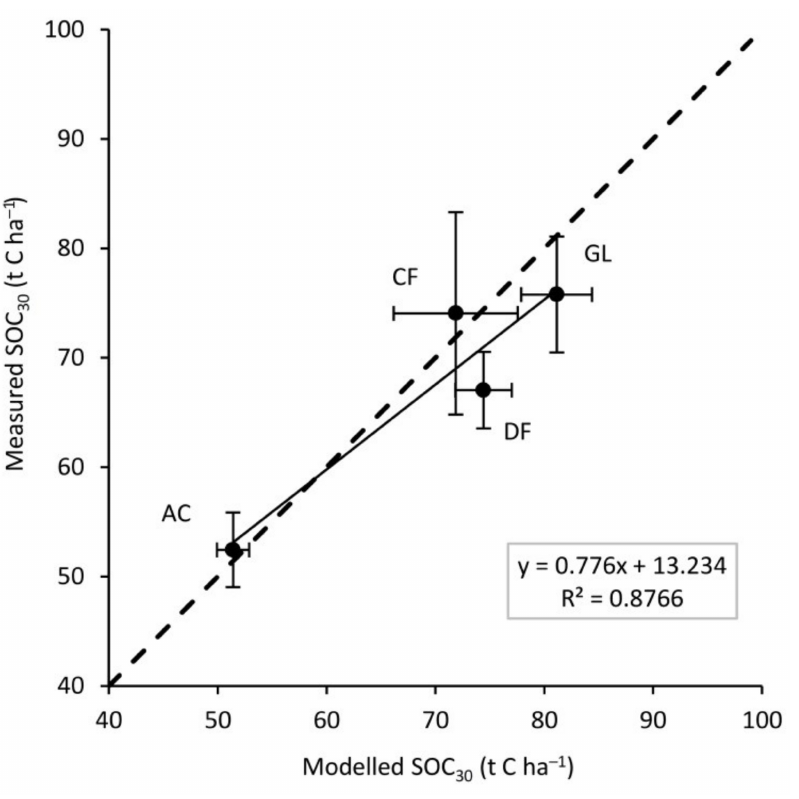
Figure 2. Comparison of measured and modelled mineral soil organic carbon stocks down to 30 cm at the level of land-use category. Average ± 1.96 SE. The dashed line is a 1:1 line. Table 2. Variability in measured and modelled soil organic carbon down to 30 cm regarding different land-use categories (average ± standard